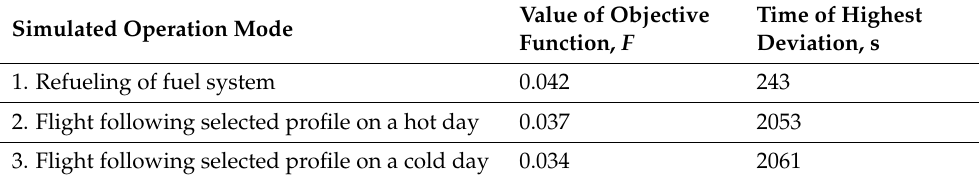
Table 5. Simulation